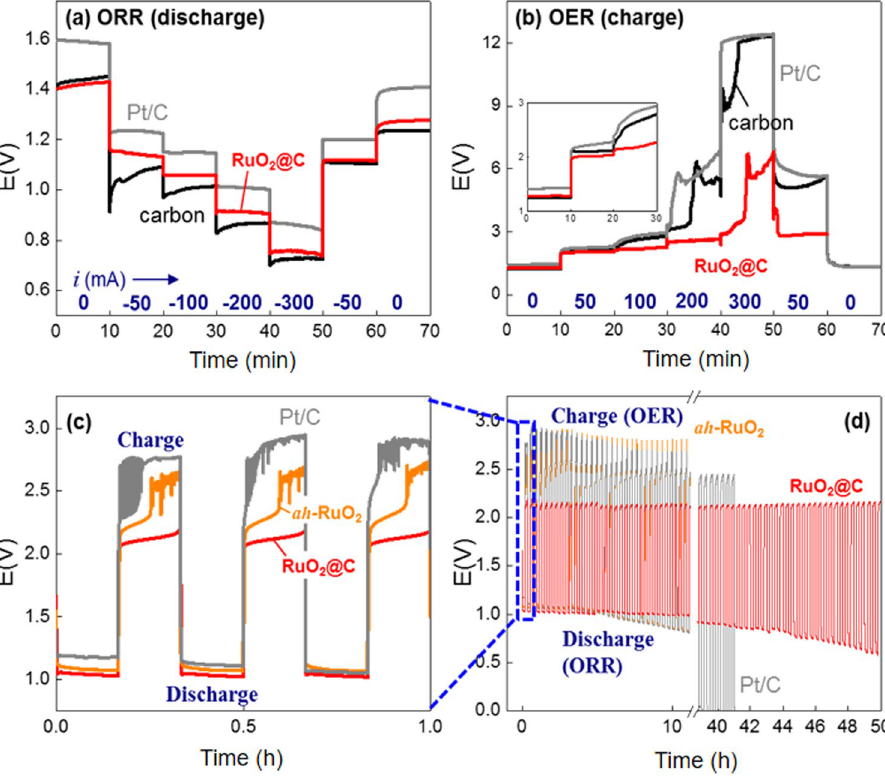
Figure 5. Zn–air batteries. 20 wt% carbon black used for RuO 2 @C. Pt loading of Pt/C is 20 wt%. ( a ) Discharge rate capability at 20 mA cm − 2 charge. ORR proceeds on air electrodes. The currents used for discharge are indicated in mA (geometric electrode area = 2.8 cm 2 ). ( b ) Charge rate capability at 20 mA cm − 2